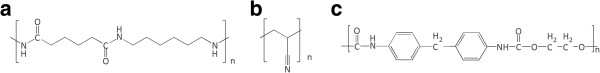
Structural units of the polymeric matrices (a) PA, (b) PAN, and (c) PUF.